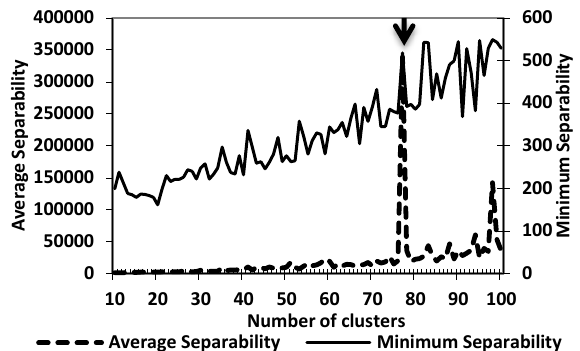
Figure 2. Divergence statistics (Avg. and Min.) used to identify the optimum number of clusters to generalise the hyper- temporal NDVI image dataset.